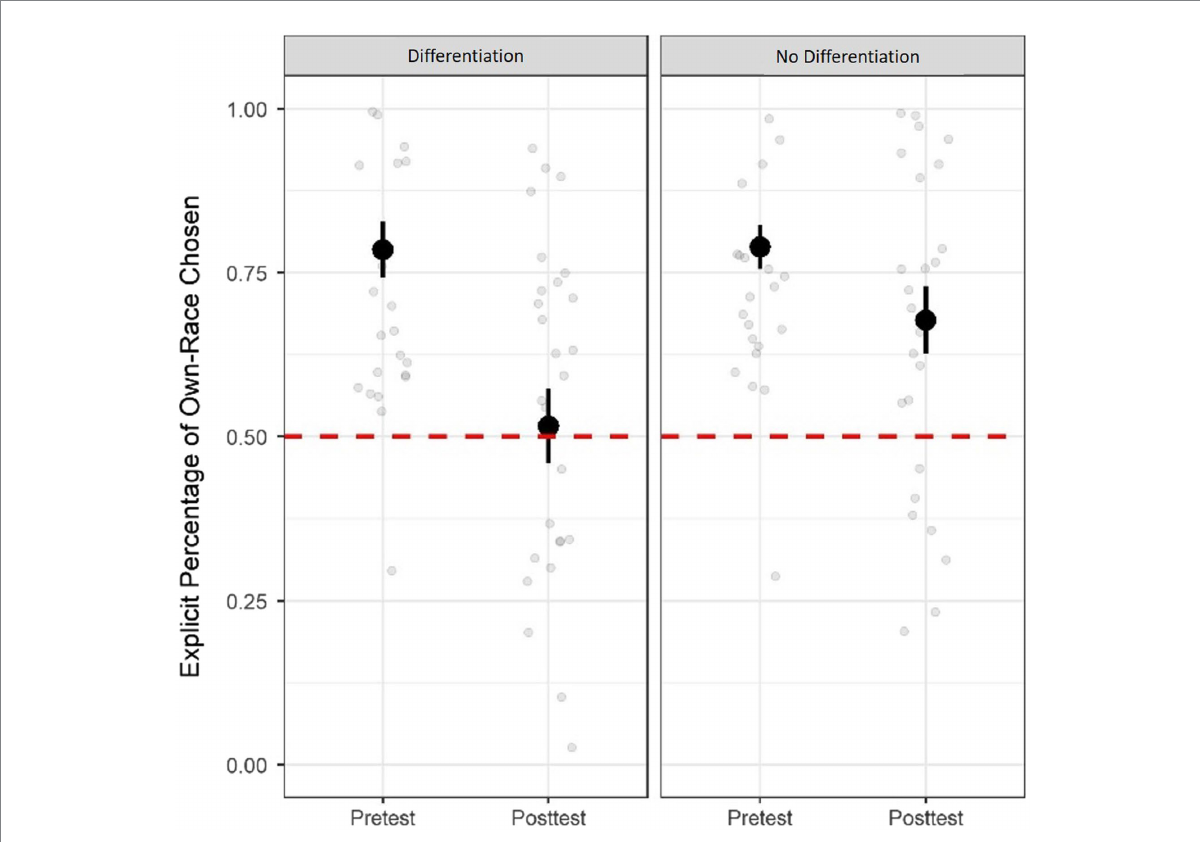
FIGURE 2 Explicit anti-Black bias at pretest and posttest for the differentiation and no-differentiation conditions. Grey dots represent each participant’s score. Error bars represent standard errors. Red dashed lines represent no